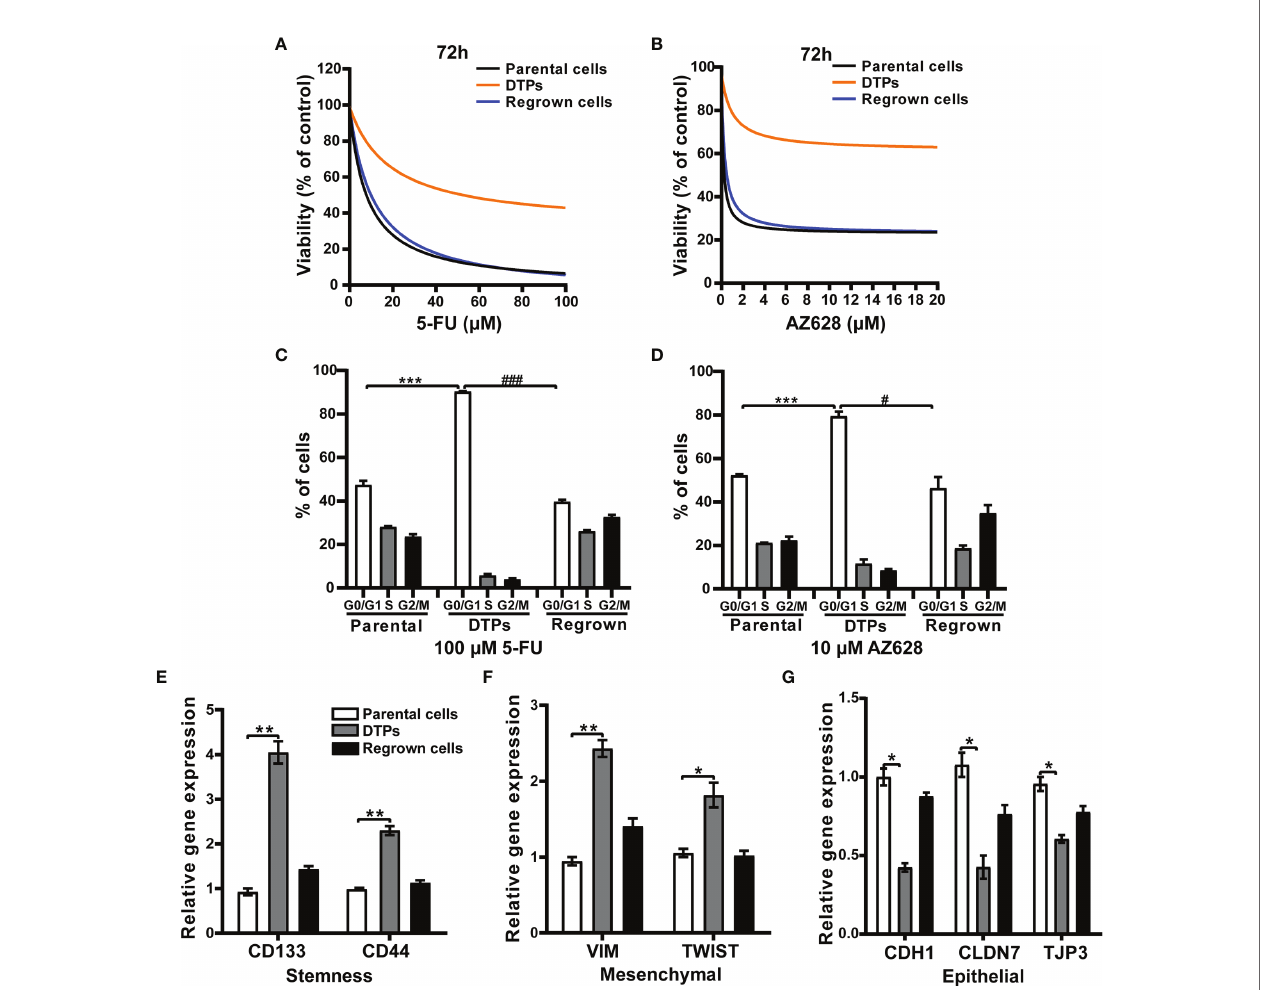
FIGURE 2 | The characteristics of drug-tolerant CRC persister cells. (A) Survival curves representing the viability of HCT116 parental cells, DTP cells generated by selection in 100 m M 5-FU, and regrown cells upon treatment with the indicated 5-FU concentrations for 72 hours. Each data point is expressed as the percentage of surviving cells relative to untreated controls. (B) Similar results were observed with AZ628. (C, D) Cells were analyzed by FACS to determine the percentage of cells in the indicated cell cycle phases. (E-G) The relative mRNA levels of (E) stemness ( CD133 and CD44 ), (F) mesenchymal ( VIM and TWIST ), and (G) epithelial ( CDH1 CLDN7 TJP3 ) markers measured by real-time PCR for the three different conditions under 5-FU treatment. Data are presented as means ± SD of two independent experiments. Statistical signi fi cance was determined using one-way ANOVA with Tukey ’ s test. *p < 0.05 vs. parental group; # p < 0.05 vs. DTP group, **p < 0.01, and ***p < 0.001 vs. parental group; ### p < 0.001 vs. DTP